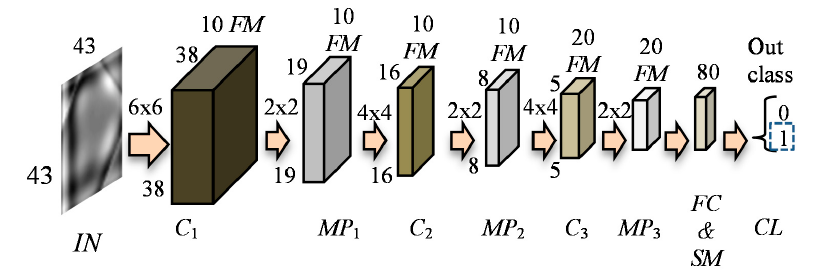
Figure 9. Schematic view of the deep convolutional neural network ( DCNN DND ) architecture for evaluation of defect occurrence; layers: IN —input, C —convolutional, MP —max-pooling, FC & SM —fully connected and softmax, CL —classification; FM —feature maps.